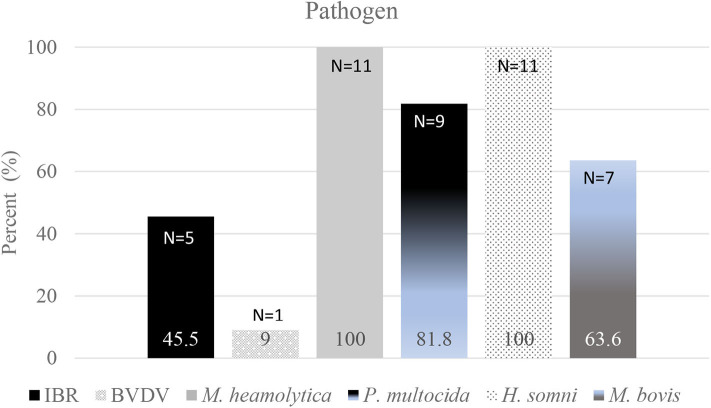
Results of rT-PCR tests to identify pathogens in samples of lung from 11 of 15 steers that died during Day 0 to Day 60. Parainfluenza Type 3 (PI3), BRSV, or BIV were not identified in any sample.